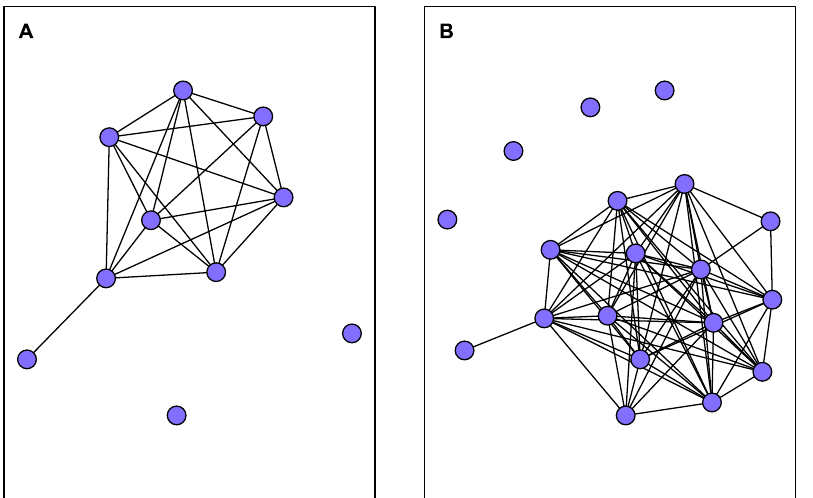
Figure 5. Indiana bat ( Myotissodalis ) foraging network maps. Foraging network maps for of an Indiana bat maternity colony in Pickaway County, Ohio, USA in 2009 (A) and 2010 (B). Connections between nodes (bats) were created when the utilization distribution overlap index for a dyad was . 1.